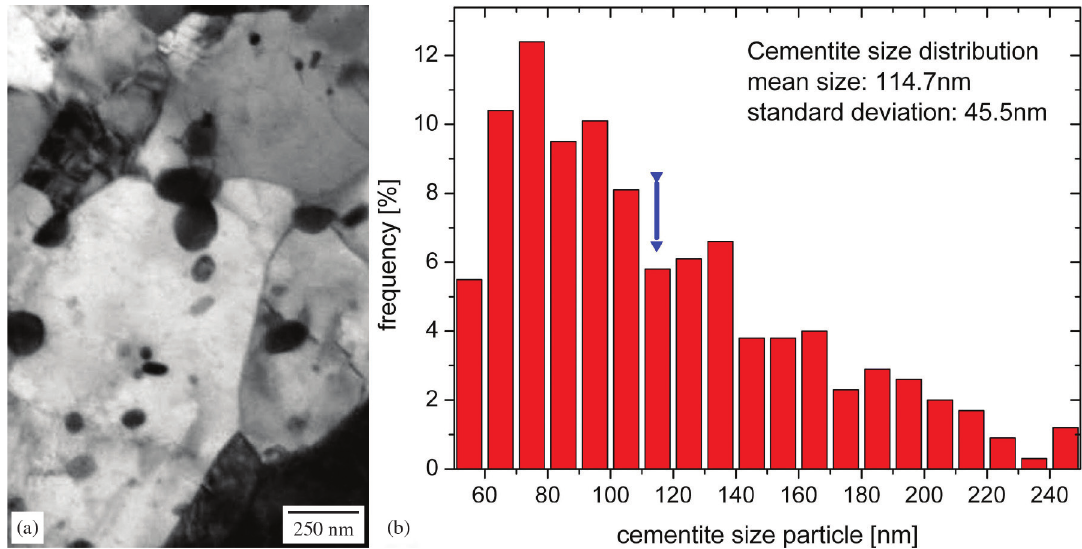
Figure 9. BF TEM micrograph showing typical cementite particles nucleated on grain boundaries and inside UFG ferrite in (a). Size distribution of cementite particles analyzed in several UFG thin foil samples in (b). Mean carbide size is indicated by